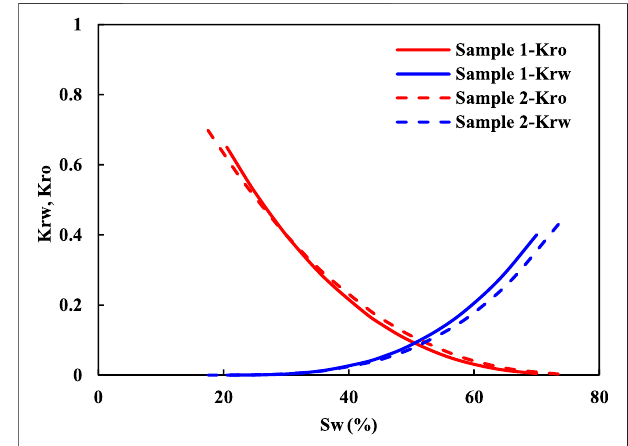
FIGURE 8 | Estimated relative permeability curves of two samples.